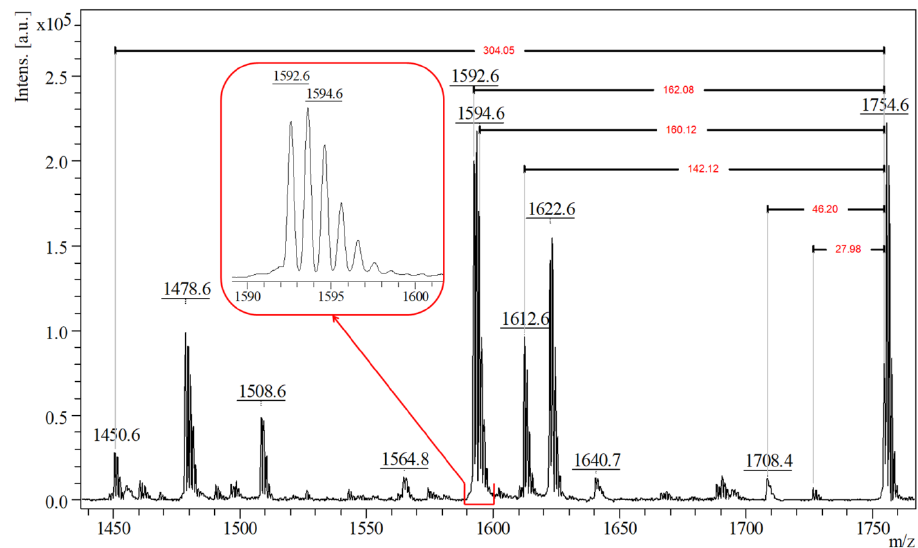
Polymers 2022 , 14 , x FOR PEER REVIEW